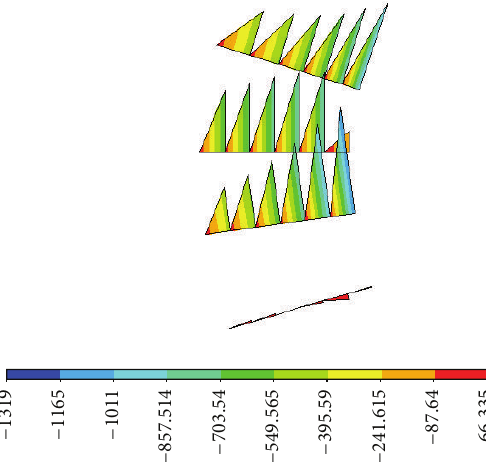
Figure 7: Axial force diagram after the secondary